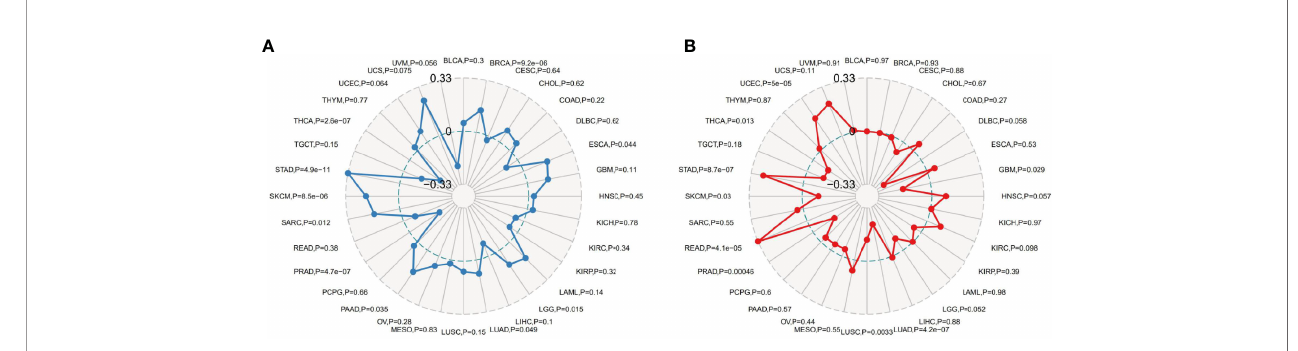
FIGURE 6 | Correlation analysis between ATG5 expression in pan-cancer and TMB, MSI. (A) Results of correlation analysis between ATG5 expression in pan- cancer and TMB described using Spearman ’ s rank correlation coef fi cient. (B) Results of correlation analysis between ATG5 expression in pan-cancer and MSI described using Spearman ’ s rank correlation coef fi